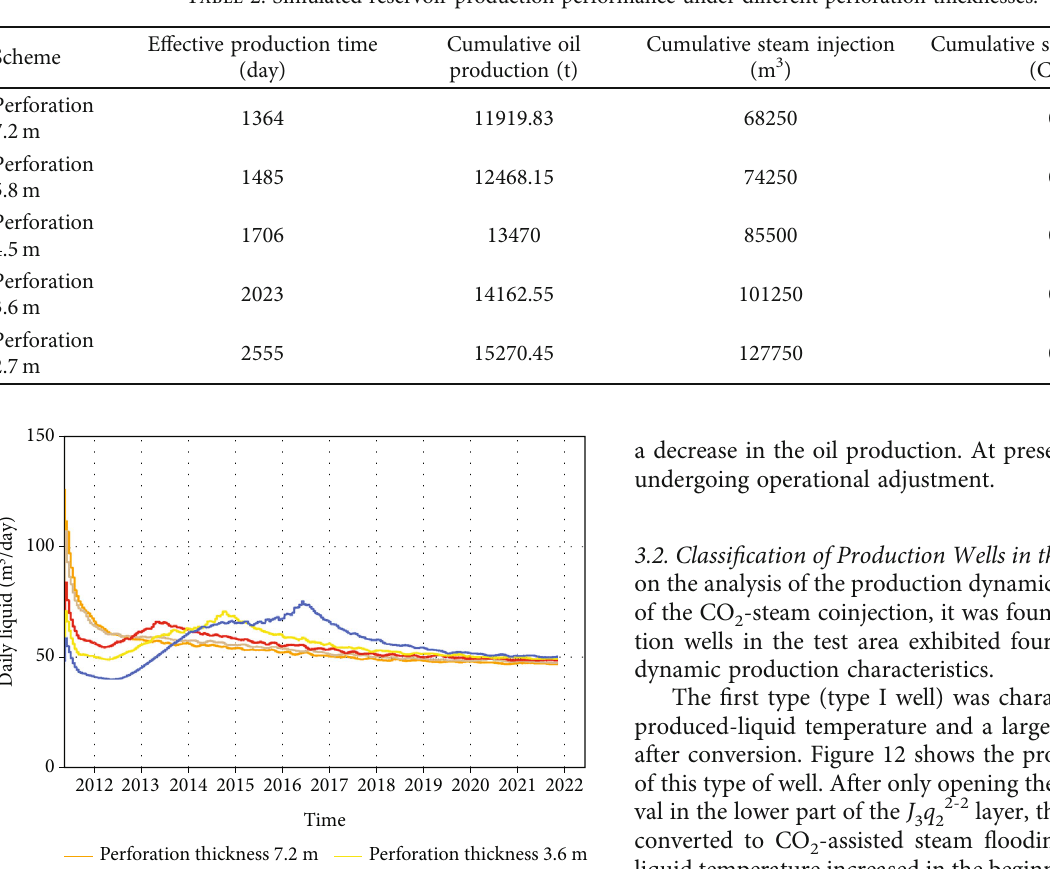
Figure 7: Adjustment of the perforation scheme. Table 2: Simulated reservoir production performance under di ff erent perforation thicknesses.